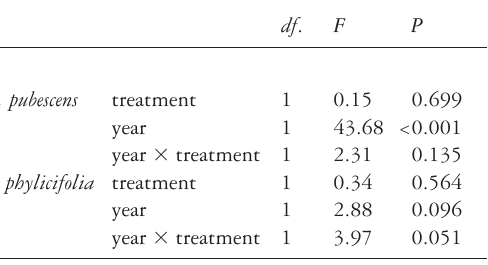
Table 3. Analysis of variance for differences in sapling height between browsing treatments and sam- pling years. Bold F and P -values indicate a sig- nificant difference between browsing treat-